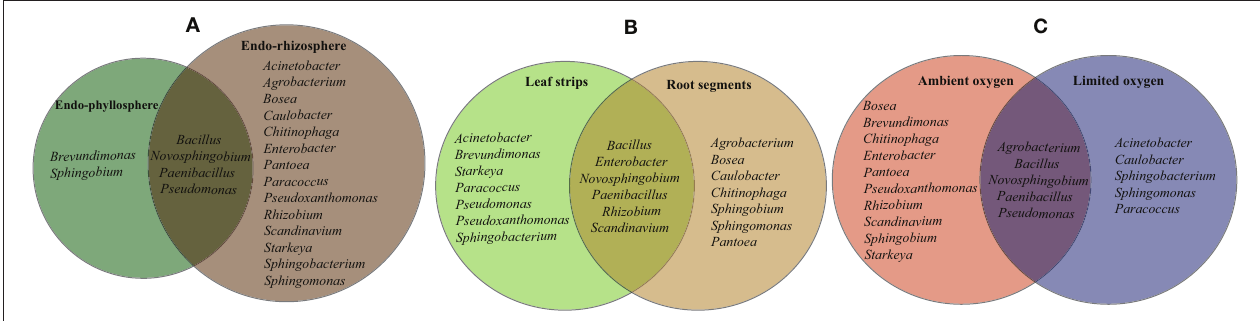
FIGURE 7 | Based on 16S rRNA gene sequences and genera identification, the diversity of sequenced isolates is significantly influenced by the single effect of plant compartments, endo-rhizosphere or endo-phyllosphere (A) , culture media based on leaf strips or root segments (B) , and incubation conditions under ambient or limited oxygen conditions (C) .